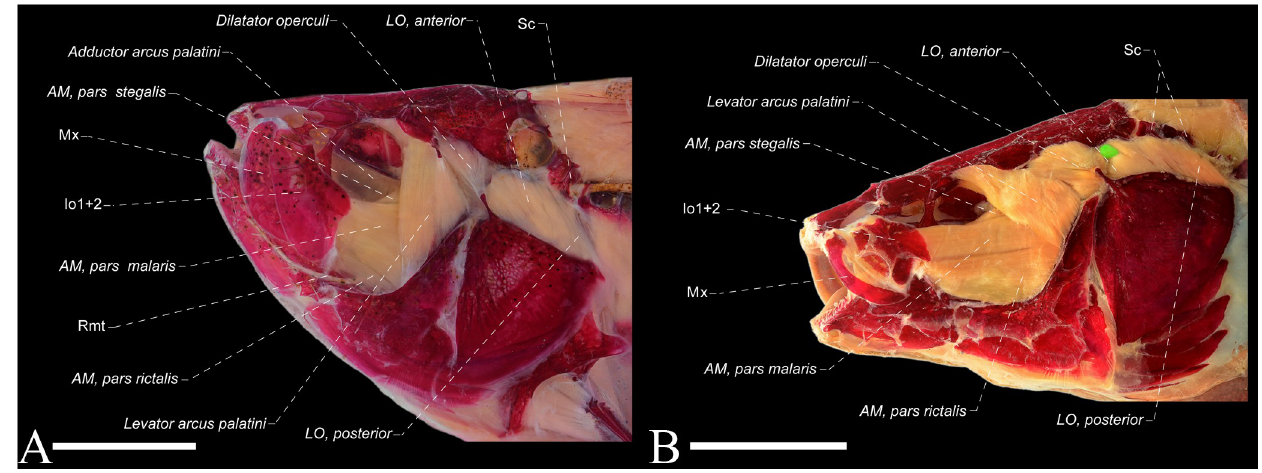
Fig 13. Lateral view of the dorsolateral head muscles of: A) Rhabdolichops troscheli , MZUSP 57704, 104.2 mm L EA and B) Sternopygus macrurus , MPEG 22756, 245.8 mm L EA . Am = a dductor mandibulae ; Io = infraorbital; Mx = maxillary bone; Sc = supracleithrum + posttemporal canal; LO = Levator operculi ; Rmt = ramus mandibularis trigeminus . Recurrent ramus of anteroventral part of anterior lateral line nerve in green. Scales: 3 mm (A) and 1 cm (B).